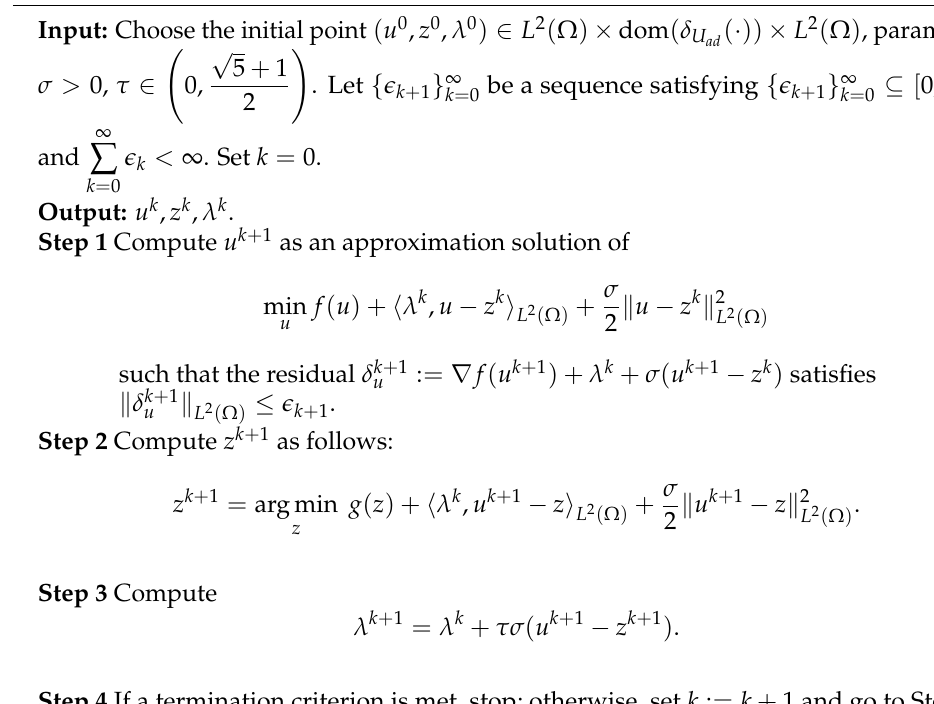
Algorithm 1 Inexact ADMM (iADMM) algorithm for